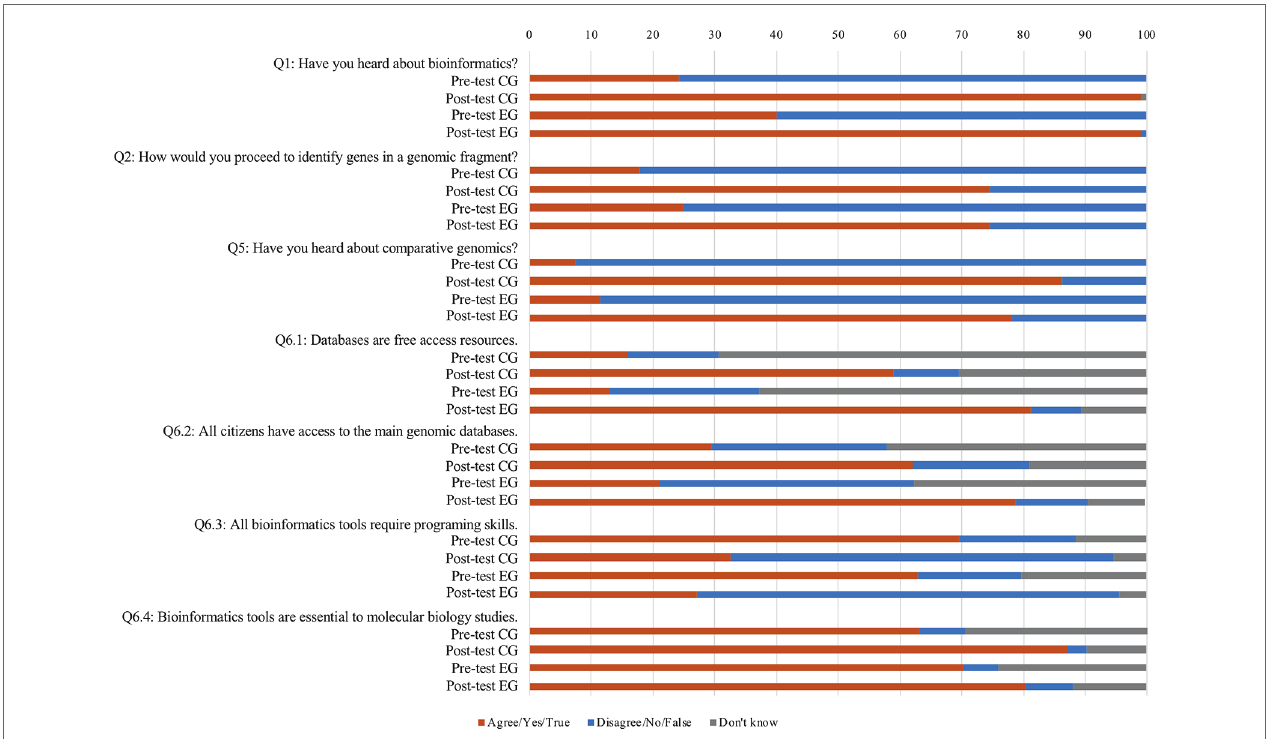
FIGURE 4 | Students’ knowledge toward bioinformatics, gene regulation, and